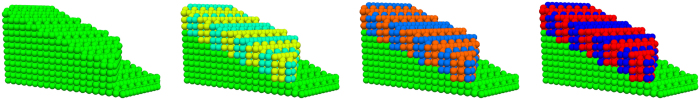
Snapshots of the (225)γ thin plate formation.Green dots: iron atoms in austenite. Blue and red dots: iron atoms in martensitic twin-related variants α1 and α3.